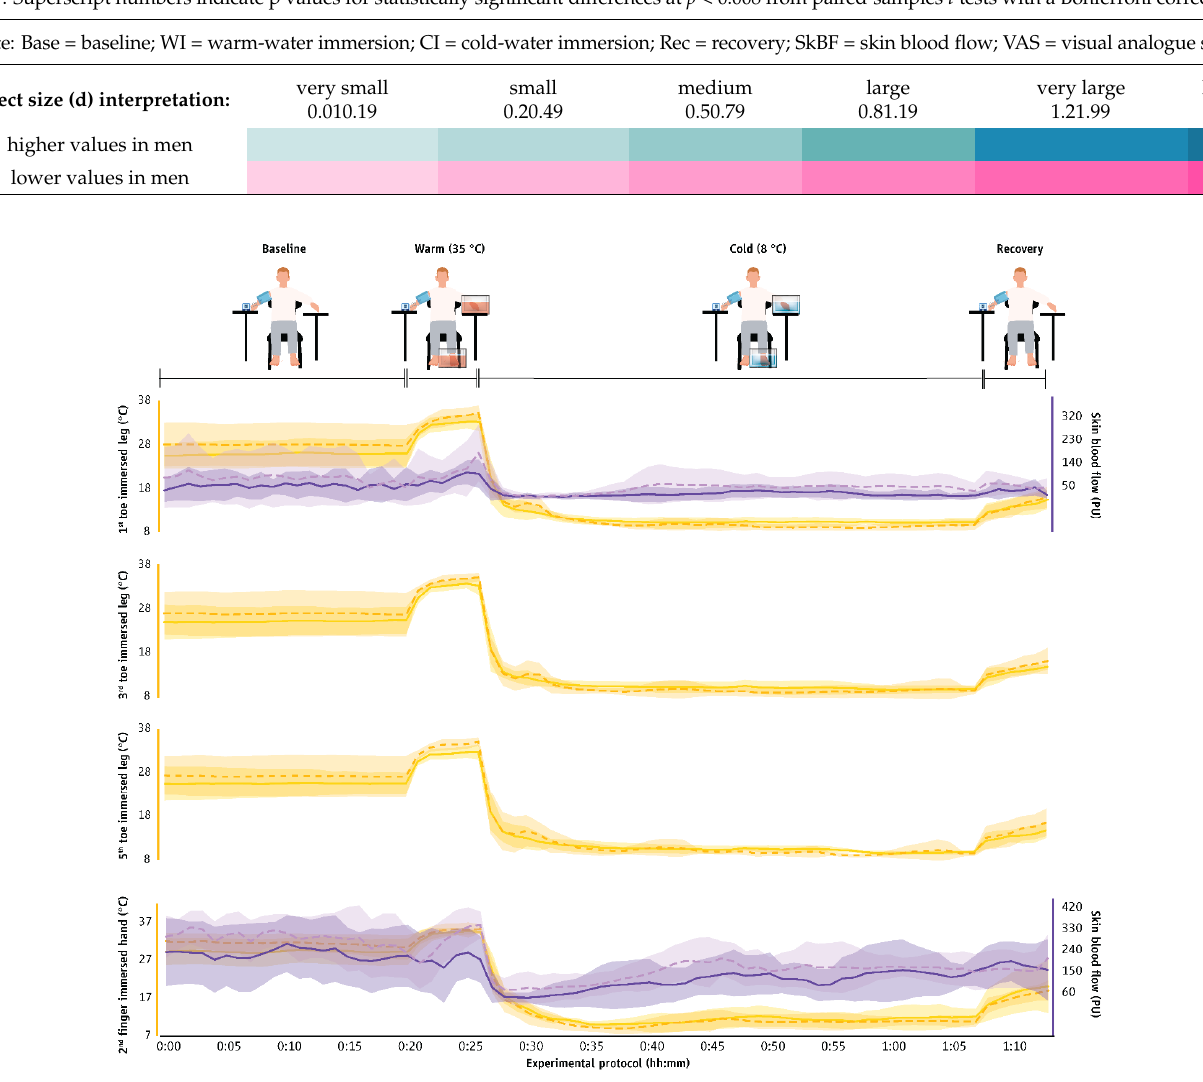
Figure A1. Skin temperature and blood flow (mean ± SD) in the fingers and toes during exposure to the thermoneutral environment (23 ± 1 °C) in the two groups. The first 20 min (00:00 to 00:20) indicate data collected during the baseline phase, the next five min (00:20 to 00:25) indicate responses during the warm-water immersion, the next 40 min (00:30 to 00:70) indicate responses during the cold-water immersion, and the final five min (00:70 to 00:75) show responses during the recovery phase. Finger and toe temperatures are indicated with continuous yellow lines in men and with dashed yellow lines in women. Finger and toe skin blood flow data are indicated with continuous purple lines in men and with dashed purple lines in